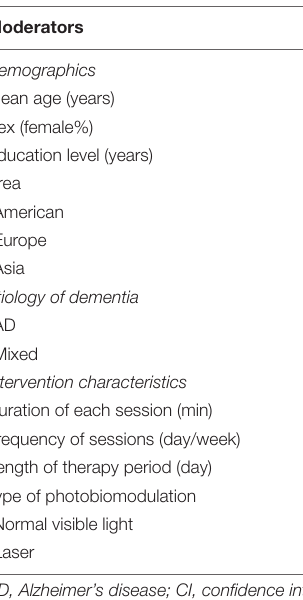
TABLE 1 | Summary of univariate meta-regression analyses for the effects on global cognitive